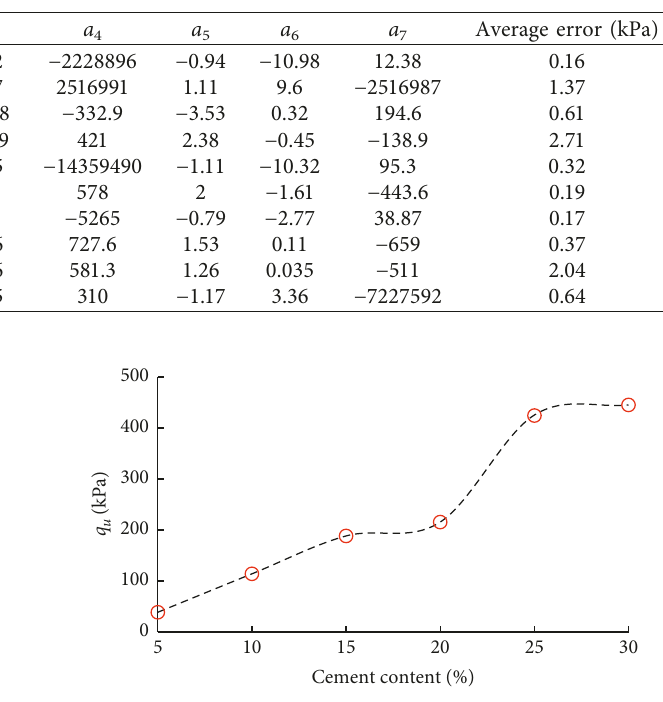
Table 2: Calculated results of parameters in BP neural network.